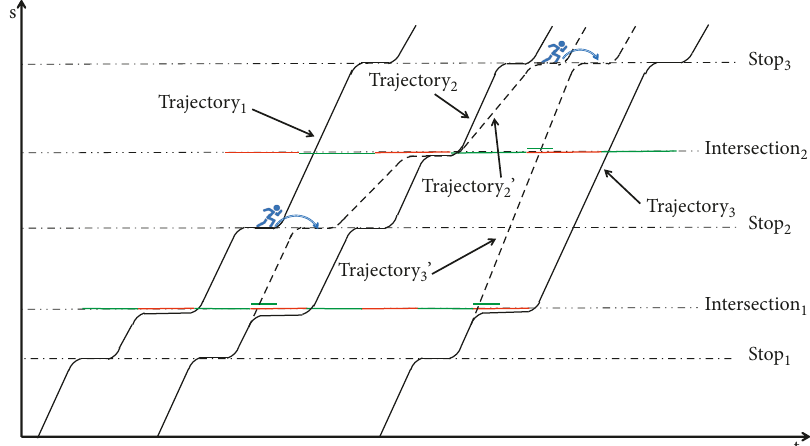
Figure 3: Vehicle trajectories under different control